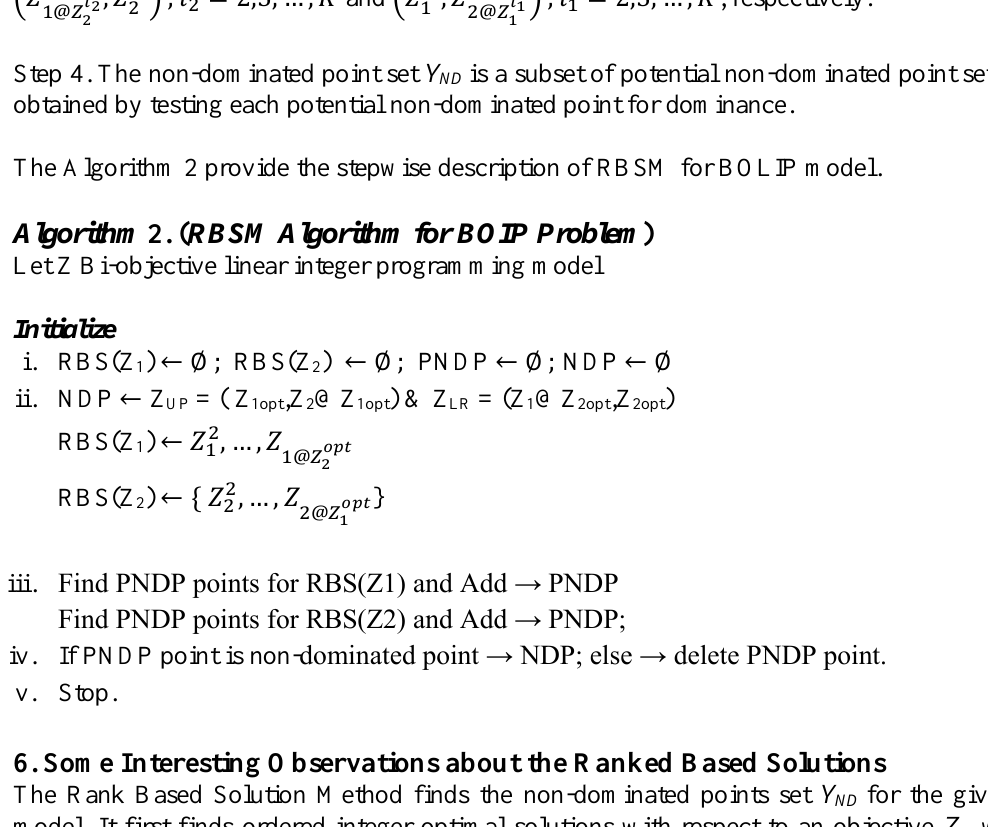
Algorithm 2. ( RBSM Algorithm for BOIP Problem